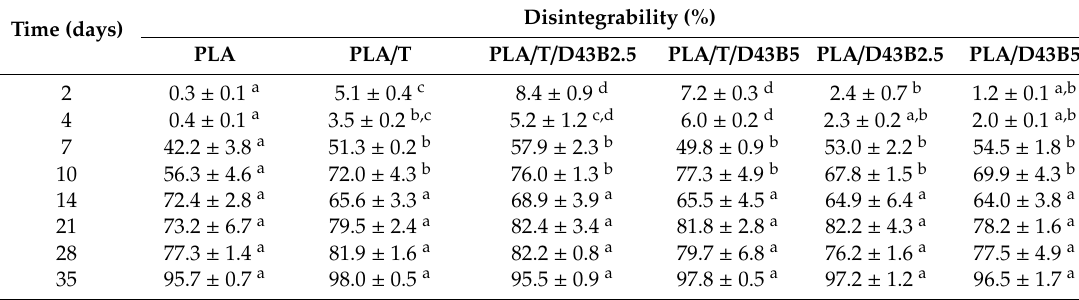
Table 3. Disintegrability values (mean ± standard deviation, n = 3, %) of PLA and nano-biocomposite films at di ff erent times under composting conditions. Di ff erent superscripts (a, b, c, and d) within the same row indicate statistically significant di ff erent